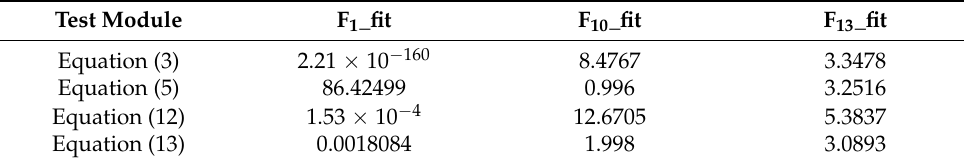
Table 1. Standard AO optimization process performance